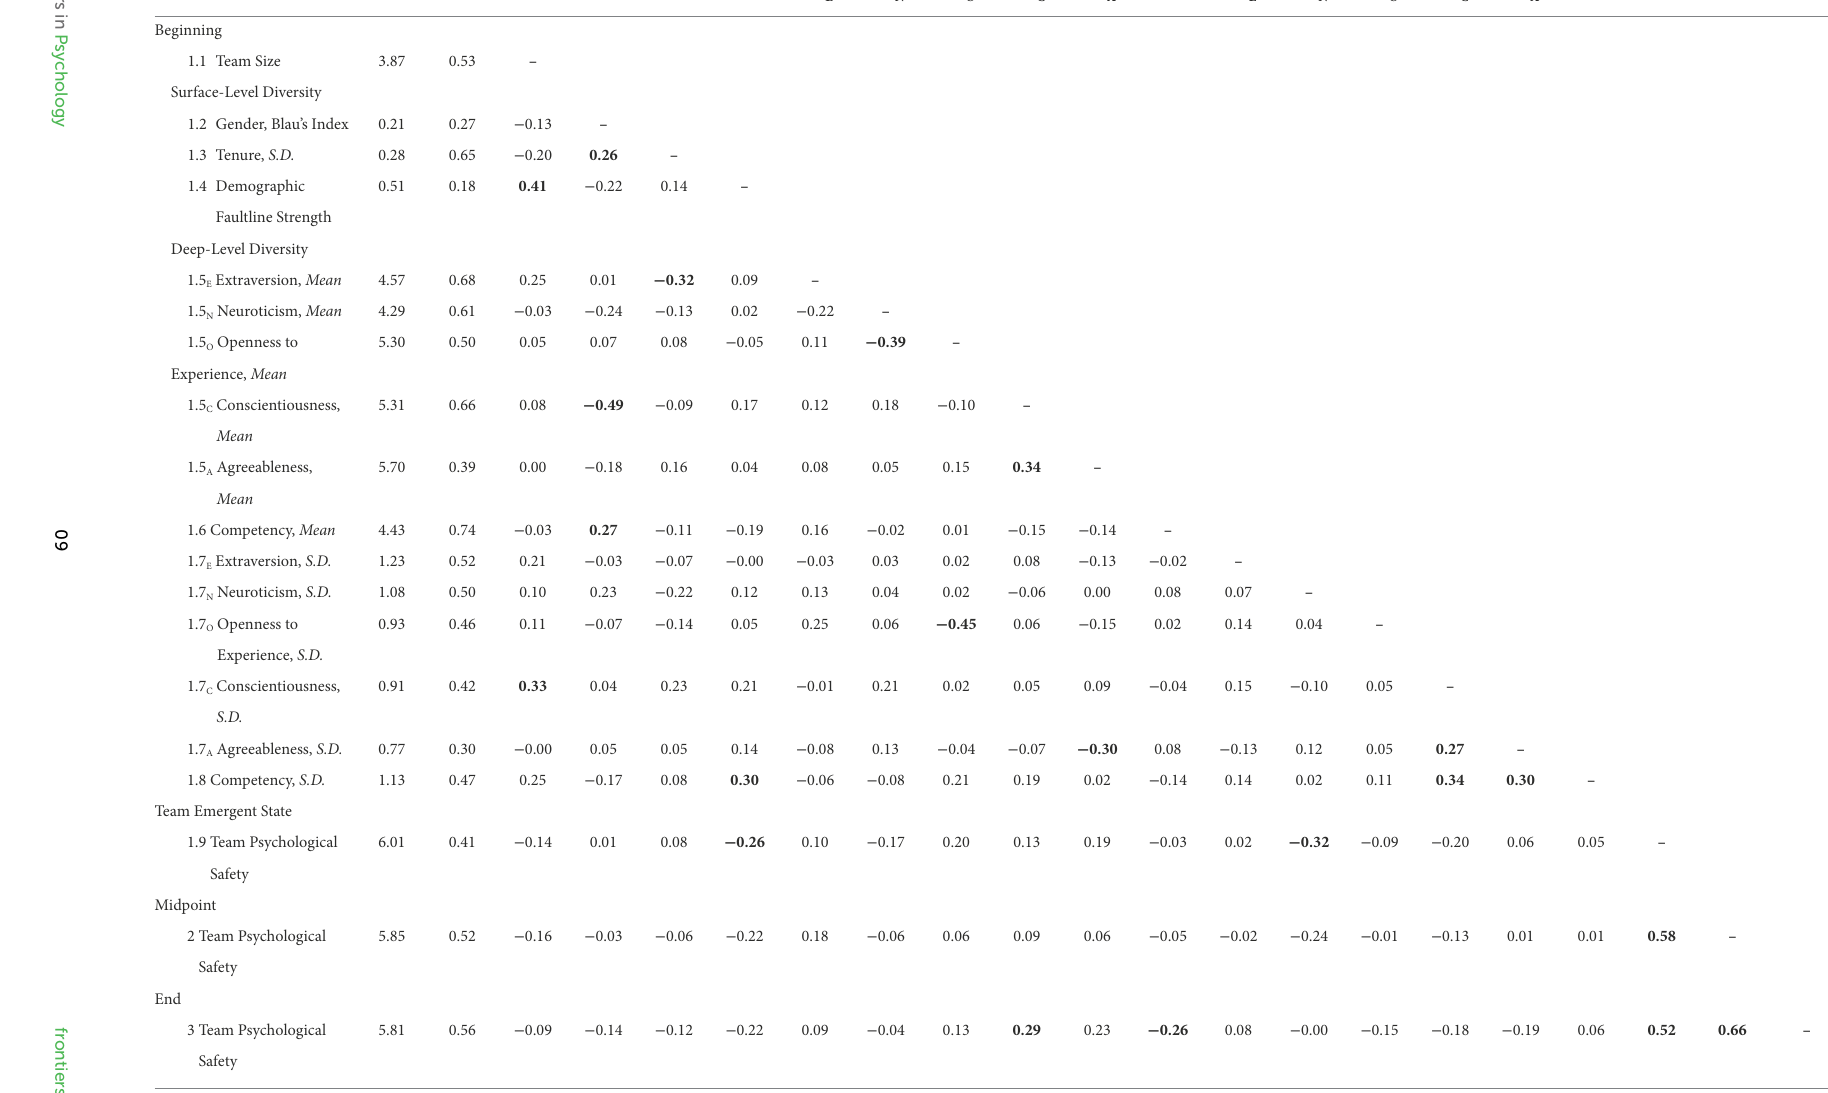
TABLE 1 Means, SD, and correlations among variables at team level at all measurement points ( N = 61 teams).